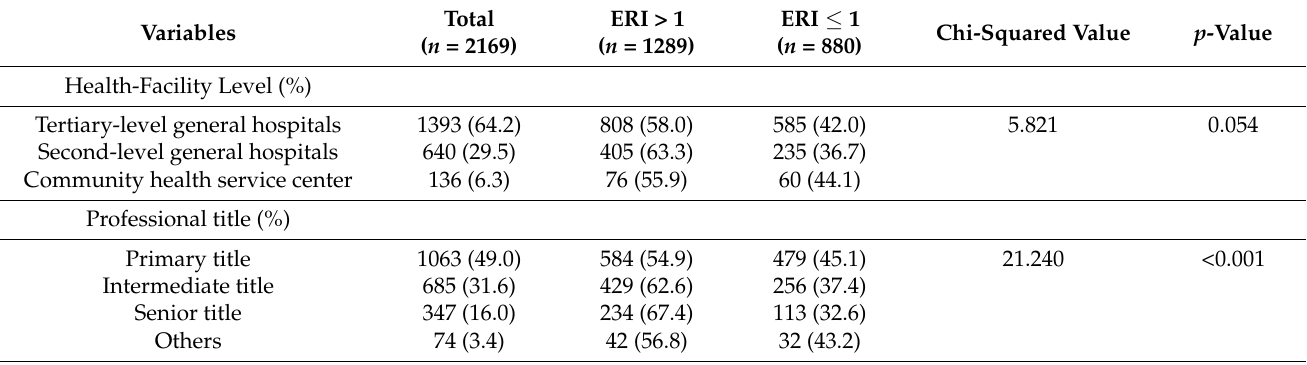
Table 2. Comparison of occupational stress levels in different occupational characteristics. ERI: Effort–Reward